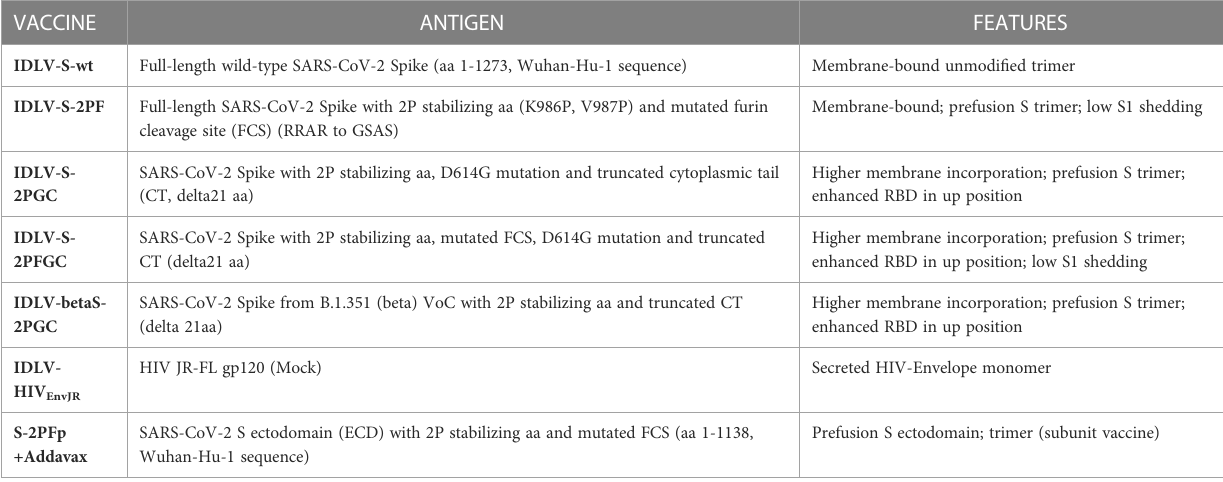
TABLE 1 Description of vaccines used in the study. VACCINE ANTIGEN